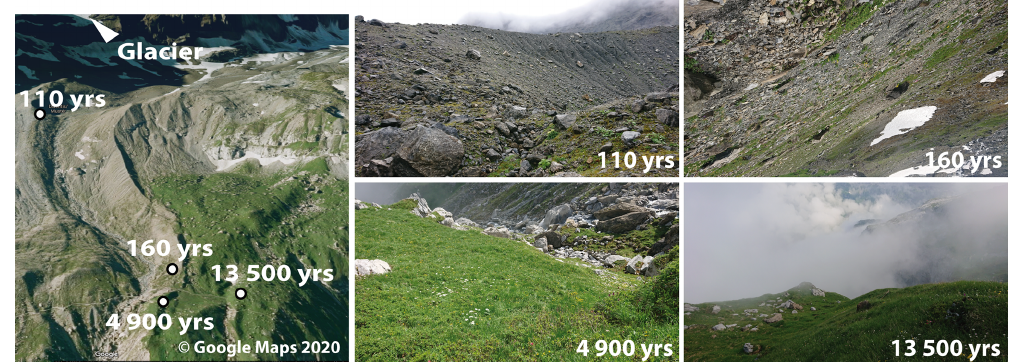
Figure 1. Location of the four selected moraines in the Griessfirn glacier forefield (left, photo by © Google Maps, 2020) and the surface cover of each age class (right). Table 1. Main plot characteristics and vegetation parameters at the tracer experiment plots (BM = above ground biomass, RLD = root length density, n.a. = analysis was not carried out).